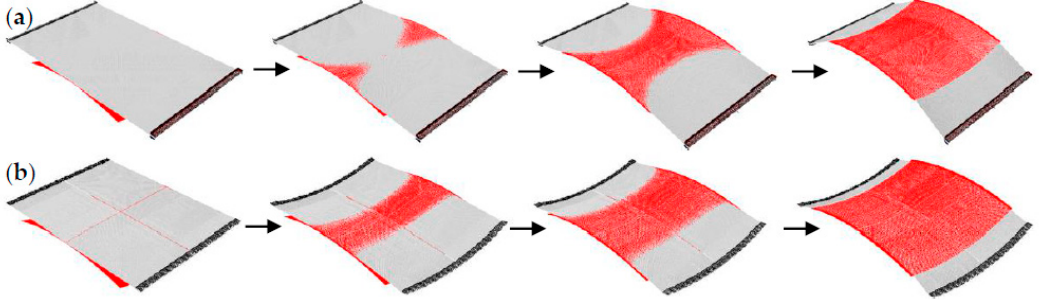
Figure 7. Contact region evolution for saddle-shaped parts. ( a ) C-SF with sheet metal of l t = 100 mm; ( b ) UC-SF with sheet metal of l t = 50 mm.